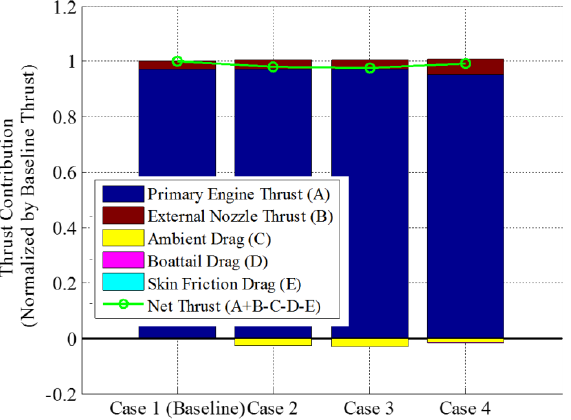
Figure 13. Thrust breakdown comparing the contribution of each thrust component to the total